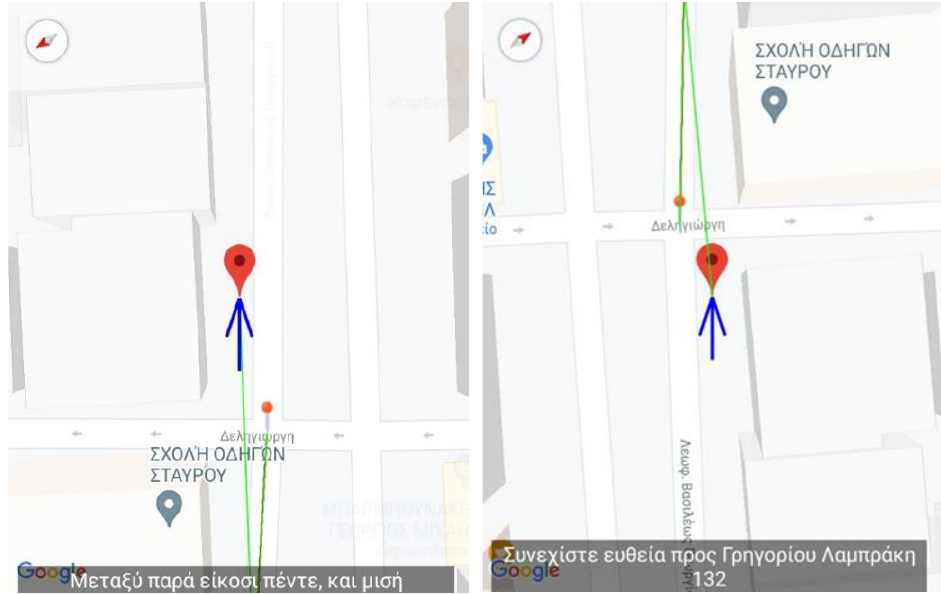
Figure 3. ( left – right ). Repositioning the user back to the correct navigational route — text in left figure: “Between 6 and 7 o’clock”; Text in right figure: “Continue onto Grigoriou Lampraki 132”.